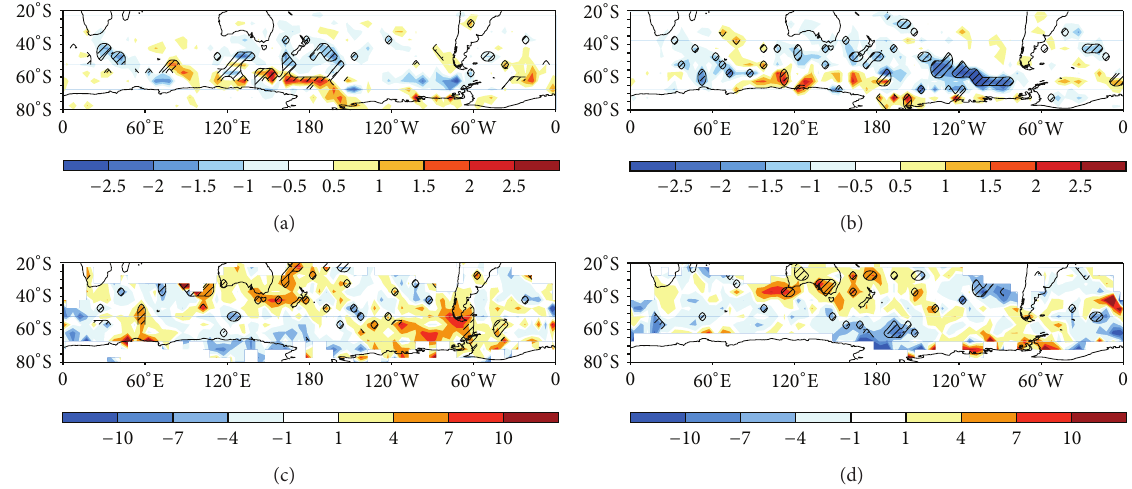
Figure 4: SH Spring (OND) IOD positive-IOD negative cyclone track frequency composite for (a) NCEP1 5801, (b) like “a” but for ERA40 5801. Units: number of cyclones. Hatched areas are significant at 90% for 2-tailed 𝑡 -test. (c) SH Spring (OND) IOD positive-IOD negative cyclone track intensity composite for NCEP1 5801 (d) like “c” but for ERA40 5801. Units: hPa. Hatched areas are significant at 90% for 2-tailed 𝑡